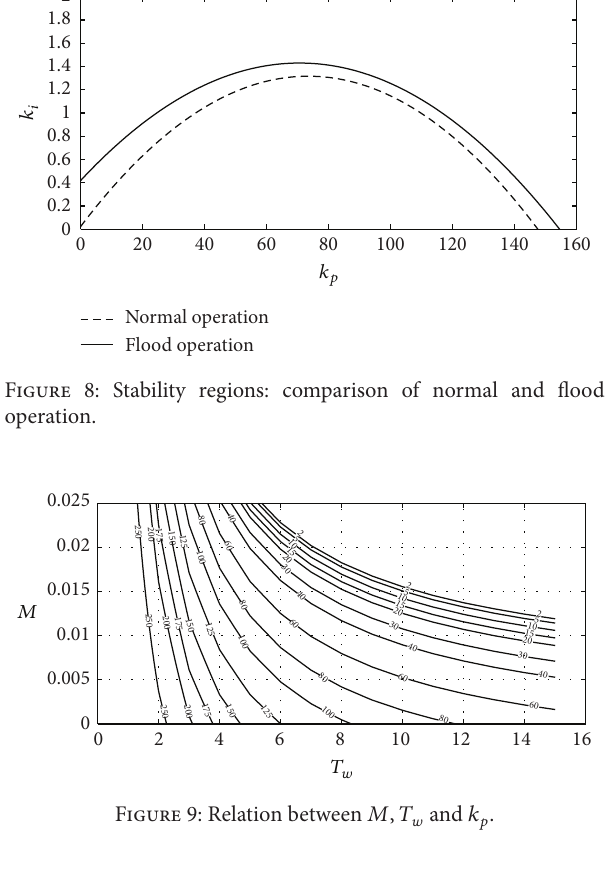
Figure 7: Stability regions: effect of the spillway dimension ( 𝑀 ).